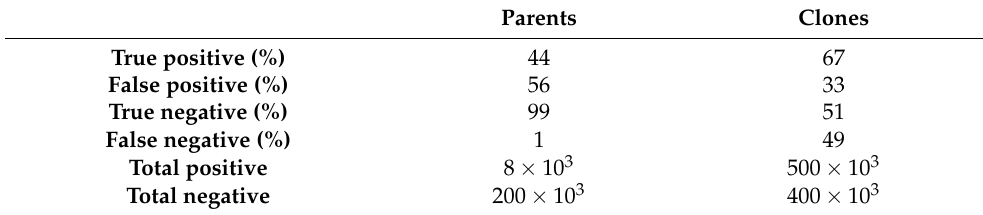
Table 4. Classifier performances in feasibility